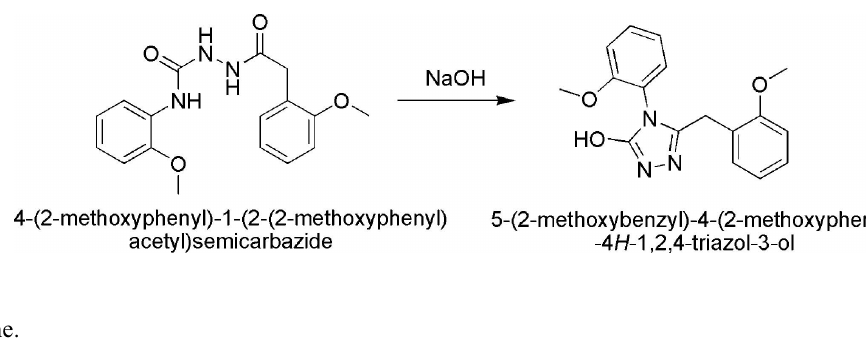
Figure 3 Reaction